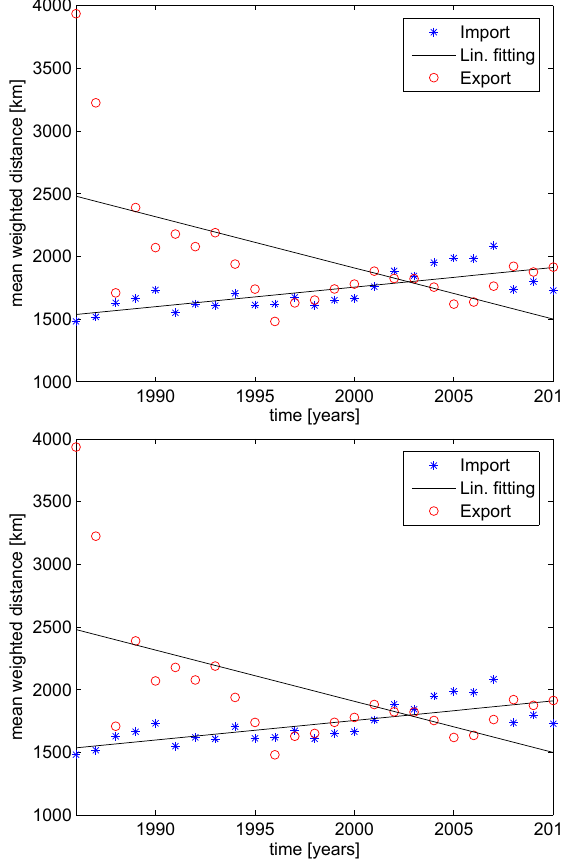
Fig. 8. Contributions of each category to the total volume of virtual water imported (left) and exported (right) in the period 1986-2010.